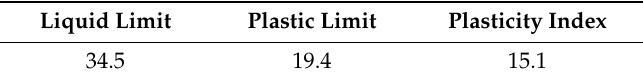
Table 3. Limits of Atterberg.